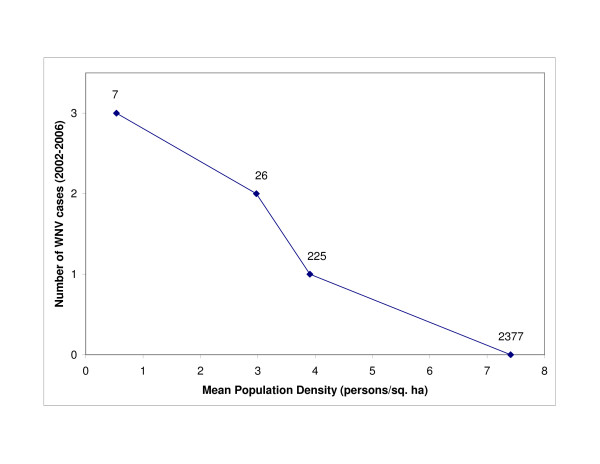
Mean population density in census block groups with zero to three WNV human disease cases (2002–2006). On the x-axis is the mean population density (persons/ha2) for census block groups calculated according to the number of WNV disease cases (i.e. 0, 1, 2, or 3 cases). The number of census blocks which had that number of cases is shown above the point in the graph.